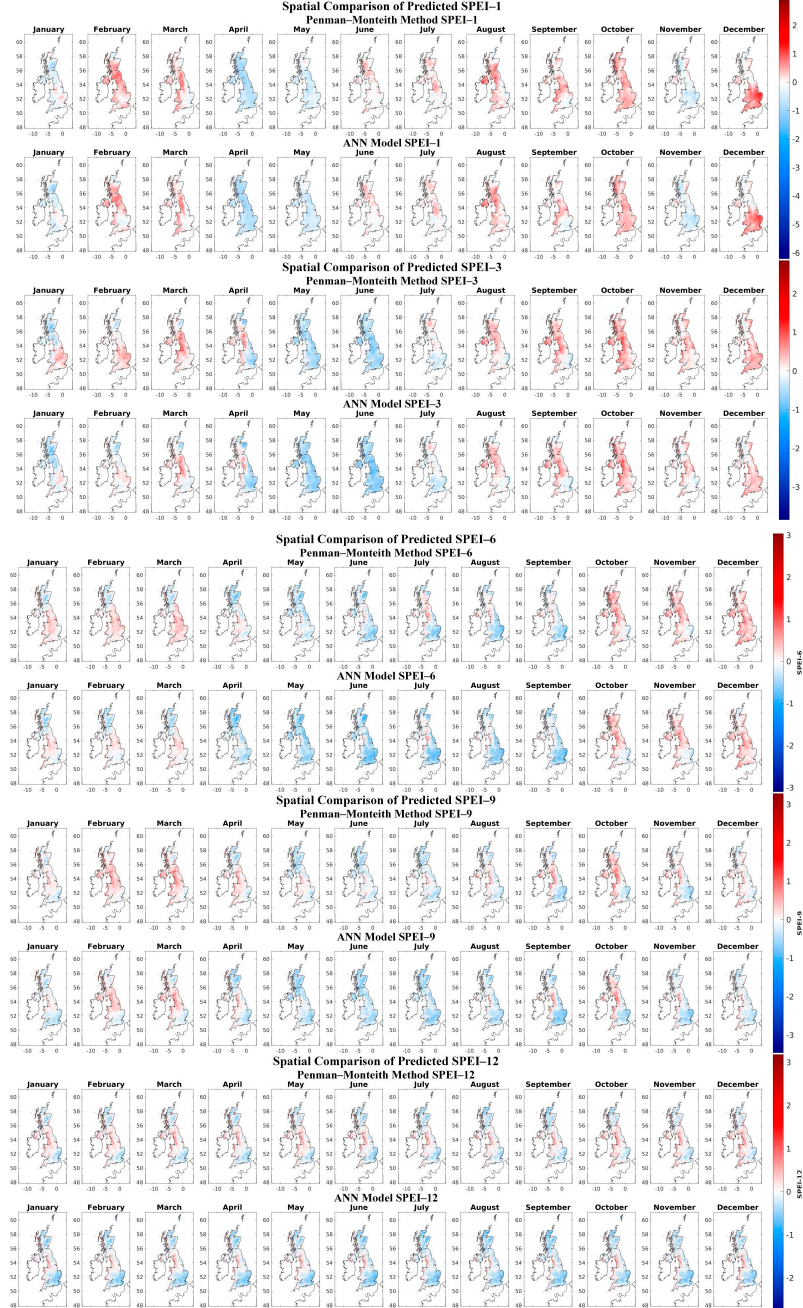
Figure 6. Monthly spatial visualization of SPEI (1, 3, 6, 9 and 12) using Penman–Monteith and ANN (prediction performance) (red indicates wet condition, and blue indicates drought condition). The visualization reveals that, on average the predicted PET, when applied to com ‐ puting drought indices does not differ greatly in comparison. However, each month is different in terms of visualization patterns during prediction, so seasonality is not inte ‐ grated into the computation of drought indices. A comparison of SPEI for predictions based on a duration of 1–month indicates that January, April, May, and November have major areas under drought conditions whereas February, March, June, July, August, Sep ‐ tember, October, and December have major areas under wet conditions. For a duration of 3 months, the drought conditions mostly prevailed in the months of April, May, June, and July, and the rest of the months present major areas under wet conditions. For a duration of 6 months, the drought conditions mostly prevailed in April, May, June, July, August,